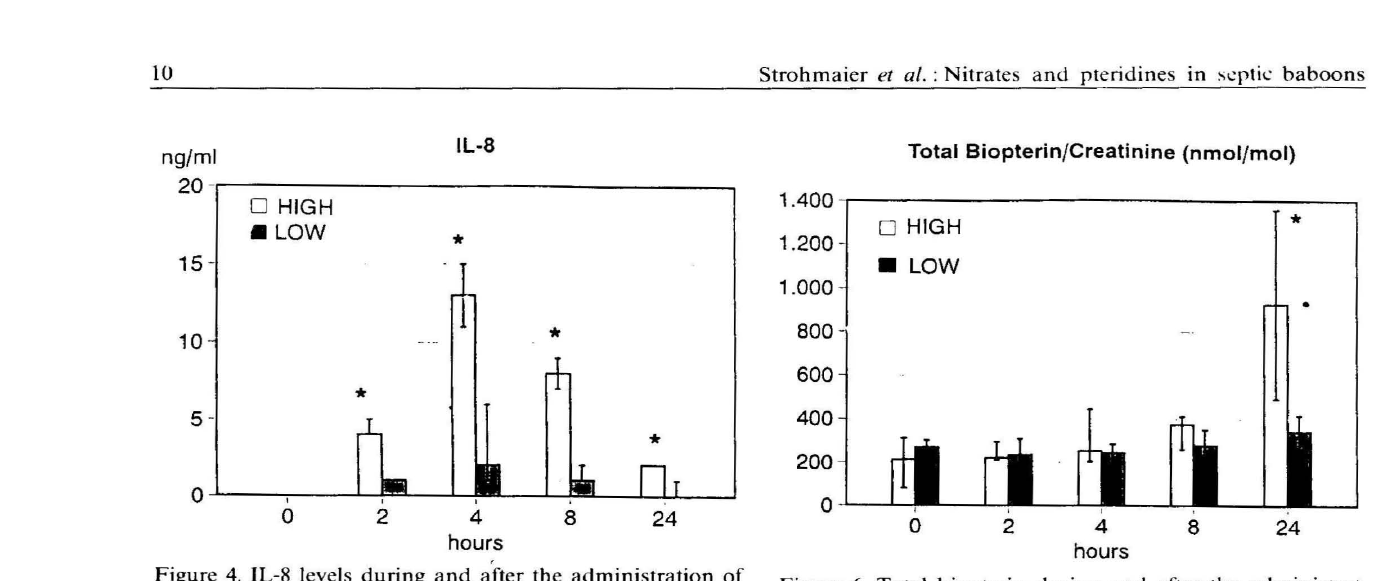
Figure 6. Total biopterin during and after the administrat ion of 2X IO'(LOW) and 2X IO"(HIGH) CFU live E. coli/ kg BW. Data are given as median and quarter percentiles. *indicates significance(p<O.OS)